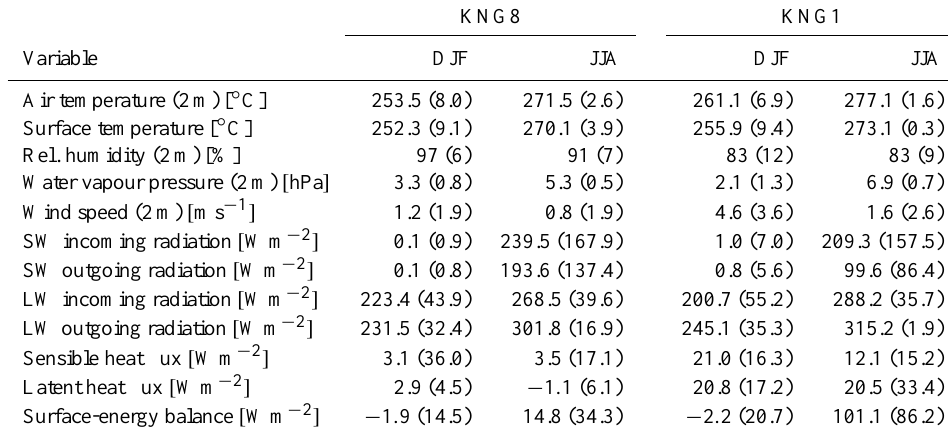
Table 3. Mean and standard deviation (brackets) of the meteorological variables and energy-balance components for the summer months (JJA) and winter months (DJF) at KNG8 and